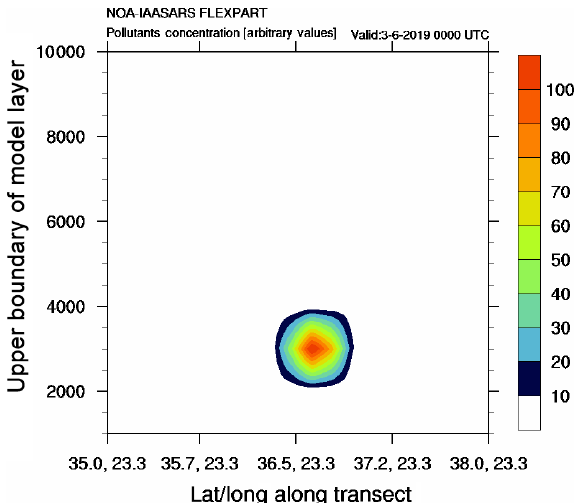
Figure 10. FLEXPART vertical cross section of the simulated vol- canic particles (in arbitrary values) over the greater Antikythera re- gion. The exact location of the cross section is indicated by the red line in Fig.